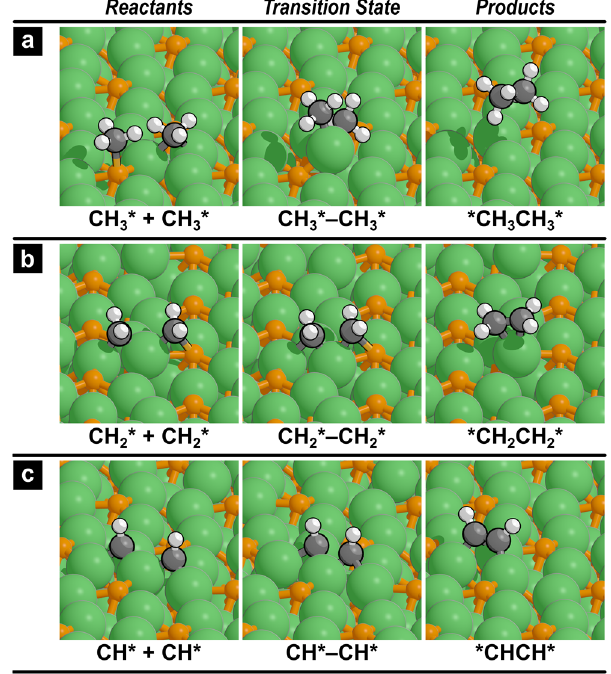
Figure 4. Reactants, transition state, and product structures for the C–C coupling reactions to form ( a ) CH 3 CH 3 , ( b ) CH 2 CH 2 , and ( c ) CHCH on Ni 2 P(001) surface. Table 3. DFT-predicted forward activation enthalpy ( Δ H act = H TS − H reactants ) and enthalpy of reaction ( Δ H rxn = H products − H reactants ) for the C–C coupling reactions on Ni 2 P(001) at 1123 K.